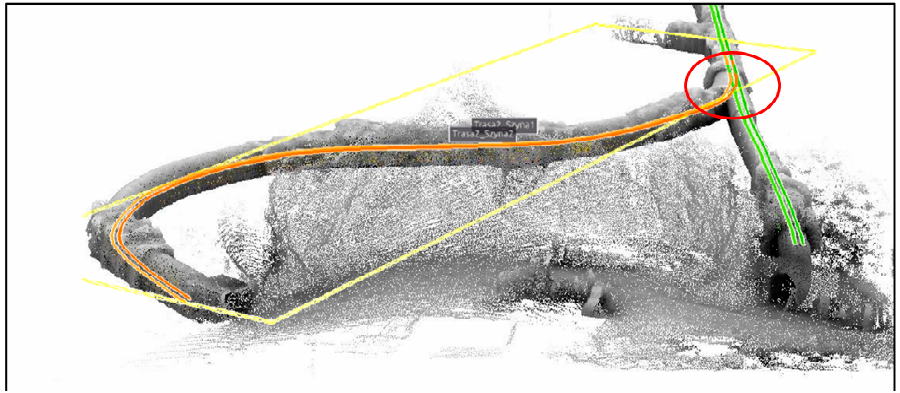
Figure 10. View of raw 3D scan of underground working and selected part for analysis (red marked area), containing transportation routes.